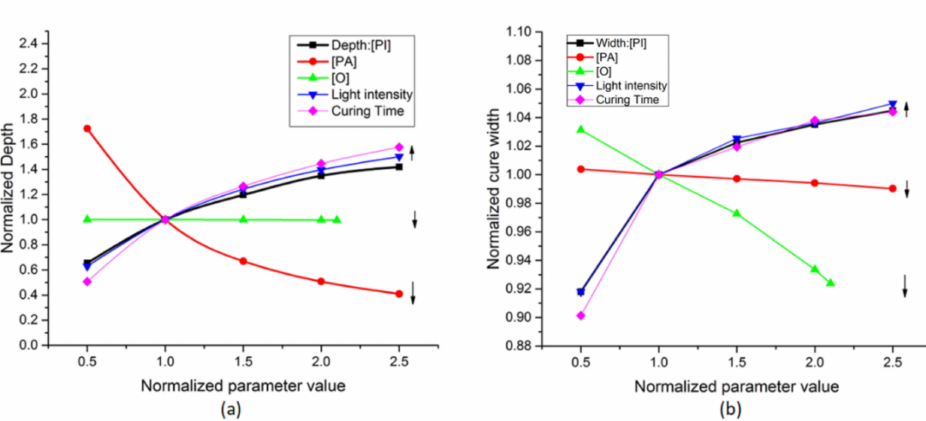
Figure 7. Effect of printing parameters on ( a ) curing depth and ( b ) curing width.